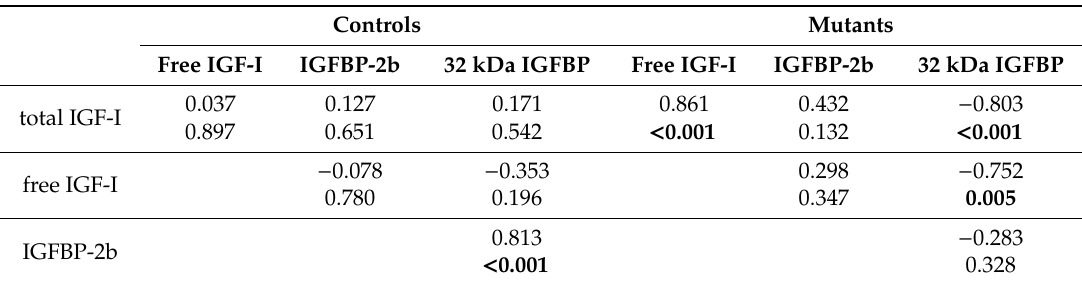
Table 2. Pearson correlations between the serum variables in controls and mutants at 15 months post-hatch. The top value in each cell is the correlation coe ffi cient; the bottom is the p -value ( n = 15). P -values < 0.05 are shown in